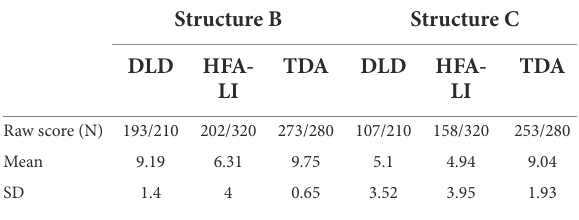
TABLE 4 Descriptive statistics of the three groups in Structures B and